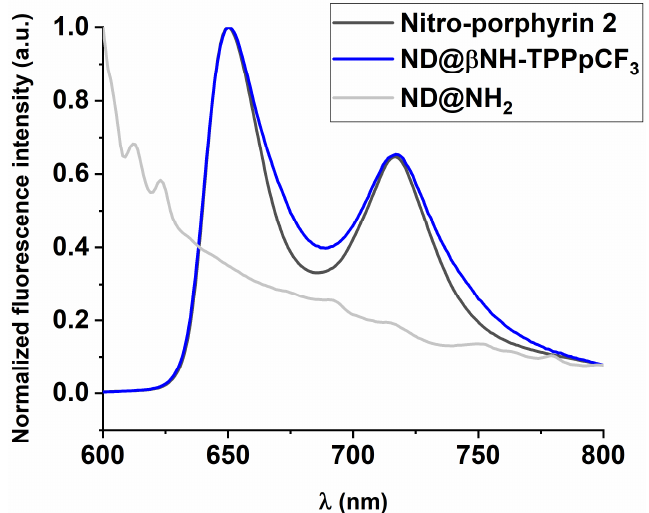
Figure 1. Normalized fluorescence emission spectra of ND@βNH-TPP p CF 3 (blue line), ND@NH 2 (grey line), and nitro-porphyrin 2 (black line) in DMF with excitation at 420 nm. The normalized UV–Vis absorption spectra of ND@NH 2 (grey line), ND@βNH-TPP p CF 3 (blue line) and nitro-porphyrin 2 (black line) dispersed in N , N -dimethylformamide are presented in Figure